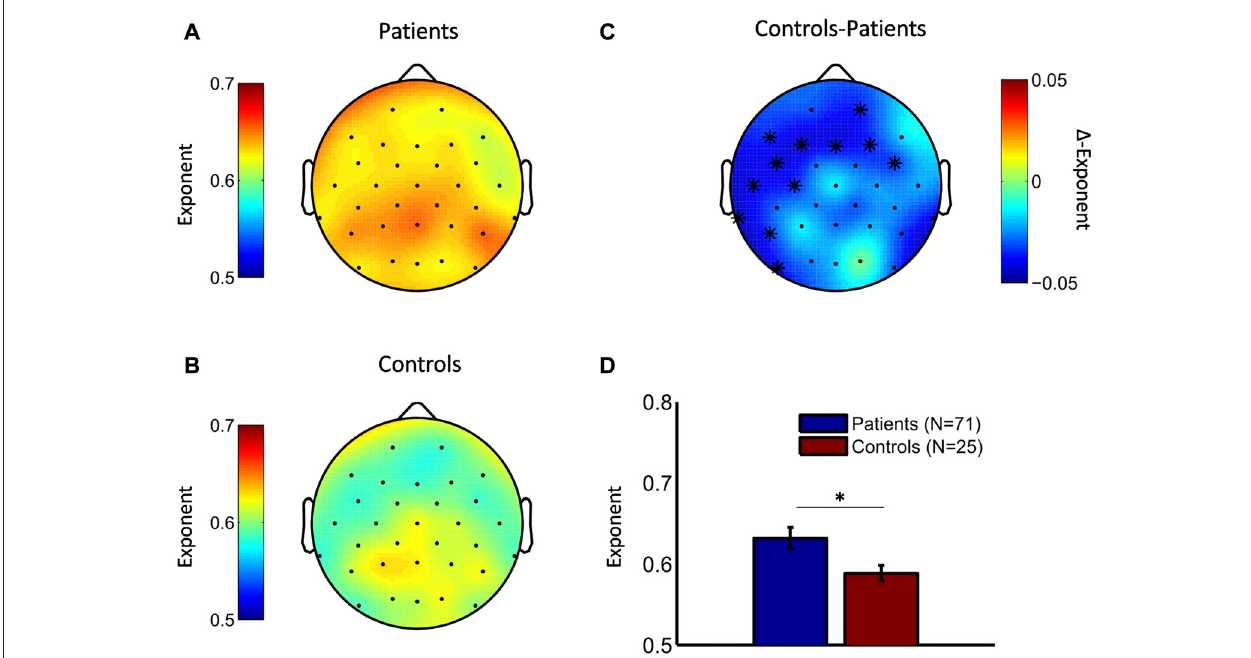
FIGURE 2 | Depressive patients exhibit stronger long-range temporal correlations (LRTC) in theta oscillations compared to healthy controls. Topographic distributions of the DFA exponents point to strongest LRTC in theta oscillations in the parietal region both in depressive patients (A) and healthy controls (B) . (C) The difference topography (controls minus patients) indicates that patients had stronger LRTC in many cortical areas. Cluster-based permutation statistic revealed a significant cluster in left temporal and frontal regions (cluster-electrodes are marked with a star). (D) Mean exponent values at a central cluster-electrode (FC5, t -statistic, ∗ p <